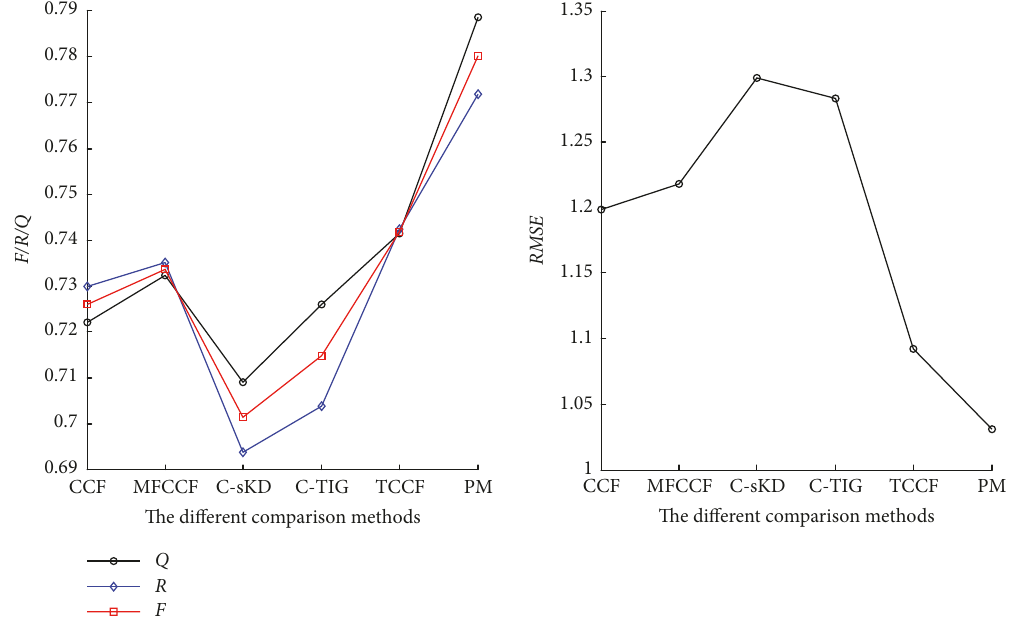
Figure 6: The comparison of the results obtained by different prediction methods in the RMM data set.